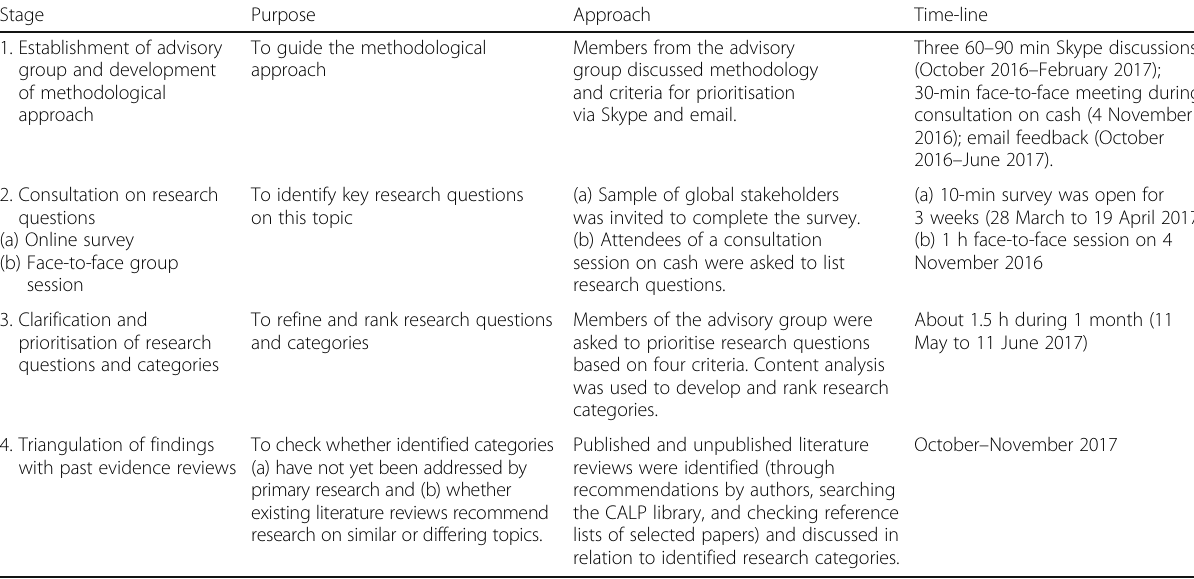
Table 1 Overview of study ’ s stages, including purpose, approach and